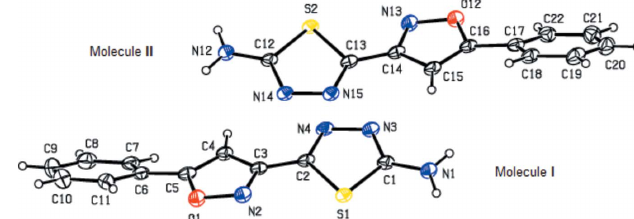
Figure 1 View of the two independent molecules, I and II, in the asymmetric unit of the title compound, with displacement ellipsoids for the non-hydrogen atoms drawn at the 30% probability level.